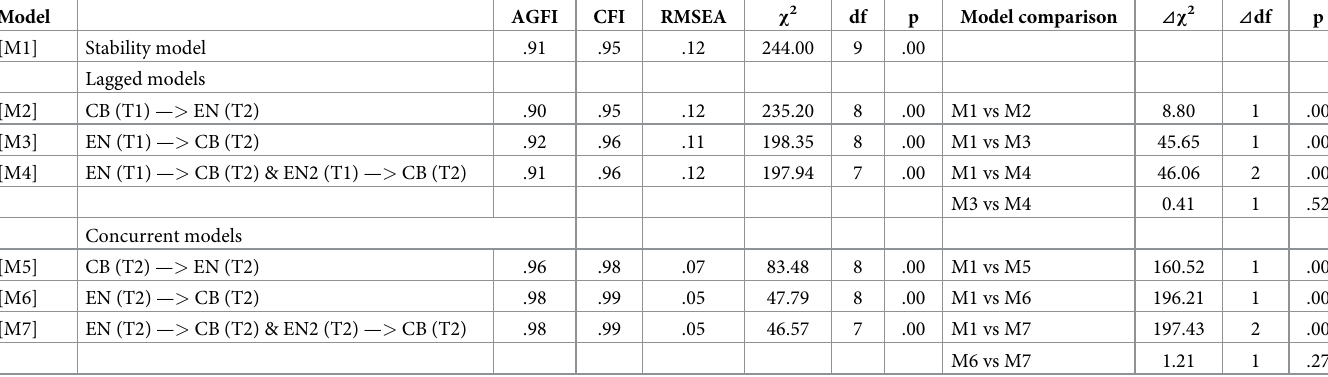
Table 4. Longitudinal relations between work engagement and creative behavior (N = 1,967).